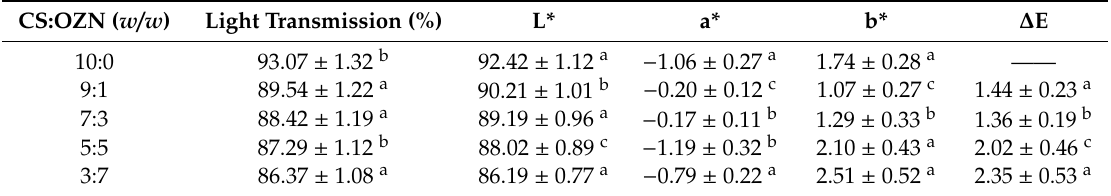
Table 3. Light transmission and color properties di ff erent CS / OZN composite